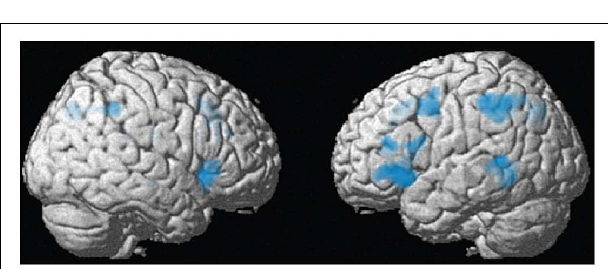
FIGURE 4 | Between-context analysis (2): whole-brain results (see also Table 1). In the left insula extending into left inferior frontal gyrus (BA 47/45), left middle temporal gyrus (BA 21), left inferior parietal cortex (BA 40), left precentral gyrus (BA 6), bilateral precuneus (BA 7), bilateral supplementary motor cortex (BA 32/8), and right insula (BA 47), there was a repetition suppression effect for repeated compared to novel syntactic structures, in the communicative as well as the non-communicative